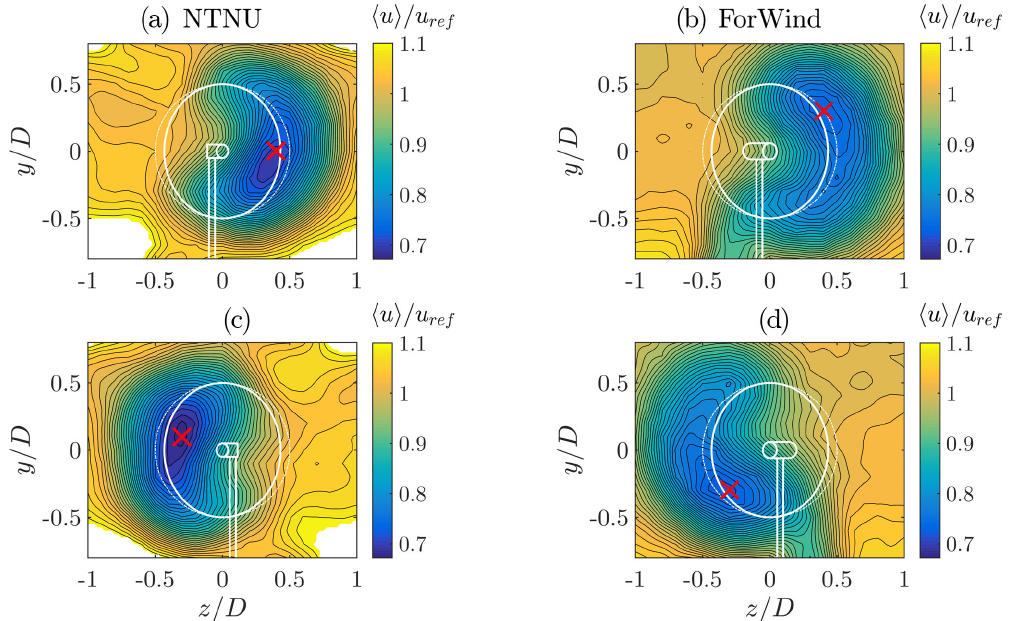
Figure 12. (cid:104) u (cid:105) /u ref during yaw misalignment. (a, b) γ = − 30 ◦ , (c, d) γ = 30 ◦ . (a, c) NTNU turbine, (b, d) ForWind turbine. The solid white lines indicate the contours of the respective turbine, while the dashed lines denote the rotor area without yaw misalignment. The red × marks the position of minimum measured velocity (cid:104) u (cid:105) . Values exceeding 1.1 are masked for better